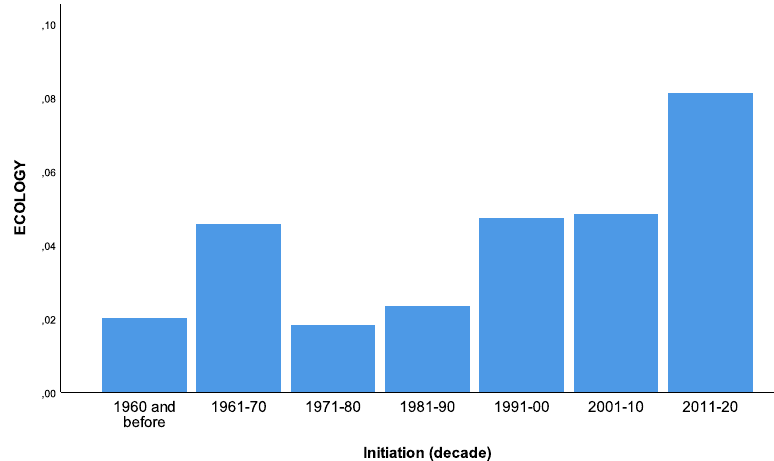
Fig. 3 Effects of decades in relation to initiation. Ecology as reason for initial involvement in relation to decade of initiation.